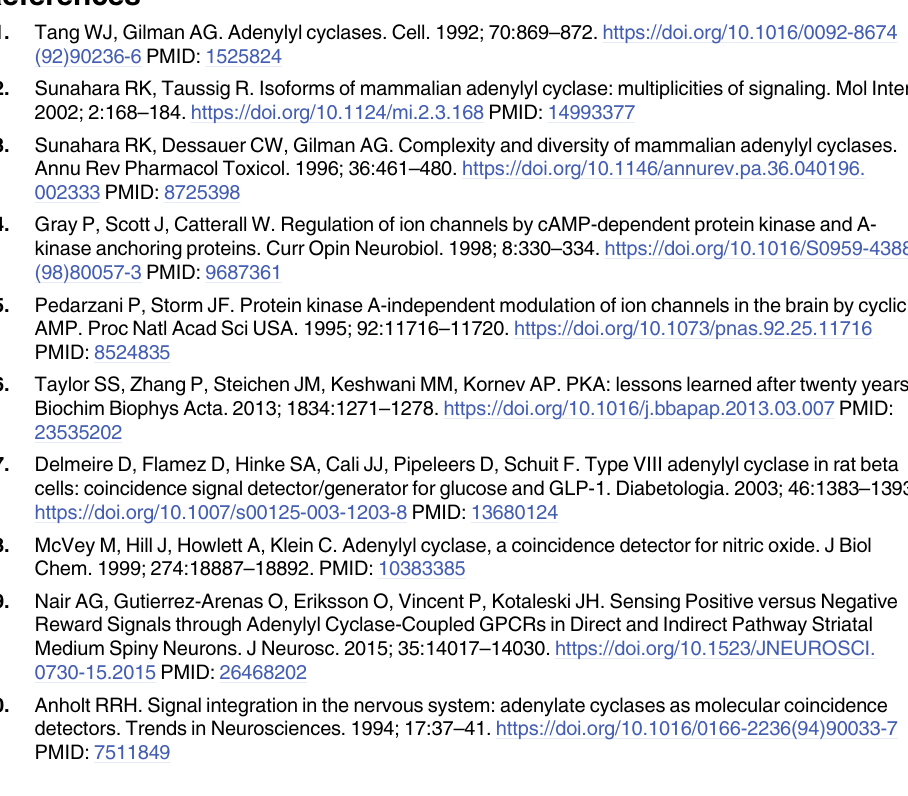
value found in the X-ray structure (PDB ID: 1CJK) is shown by a green dashed line. (E,F,G,H) represent the respective values reported in (A,B,C,D) obtained in the second run of the